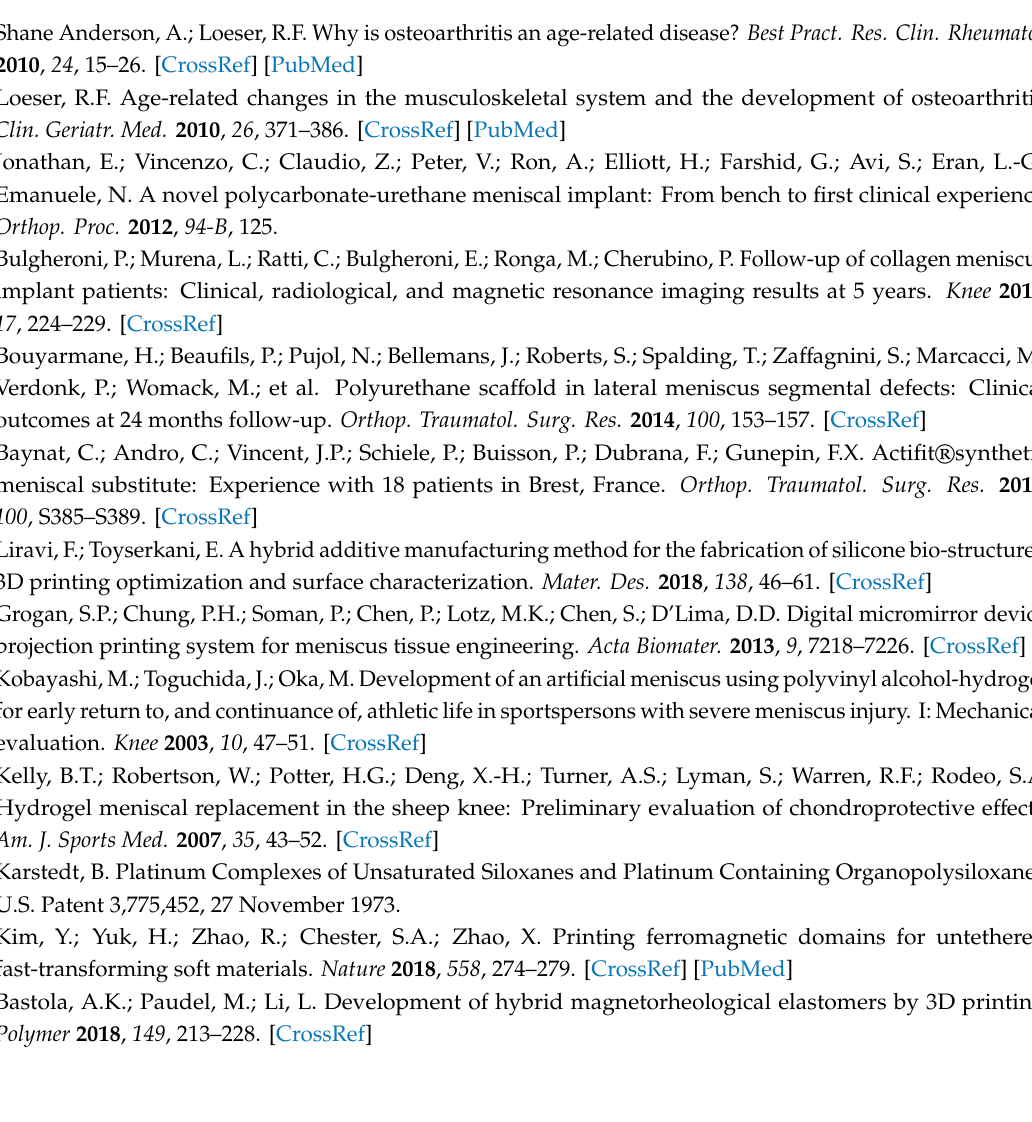
Figure S1. Compression plates set-up used for static compression test. Figure S2. XPS spectra of (a) molded and (b) 3D printed silicone implant. Figure S3. Combined (a) DSC, (b) TGA, and (c) DTG graphs of 3D Printed and Molded Eco30 and Eco50 samples. Figure S4. Fluorescent and corresponding optical images of L929 cells attached and proliferating on surfaces of 24-well cell culture plates after 24, 72, and 120 h culture. Cells were stained with the Live / Dead ® cell viability